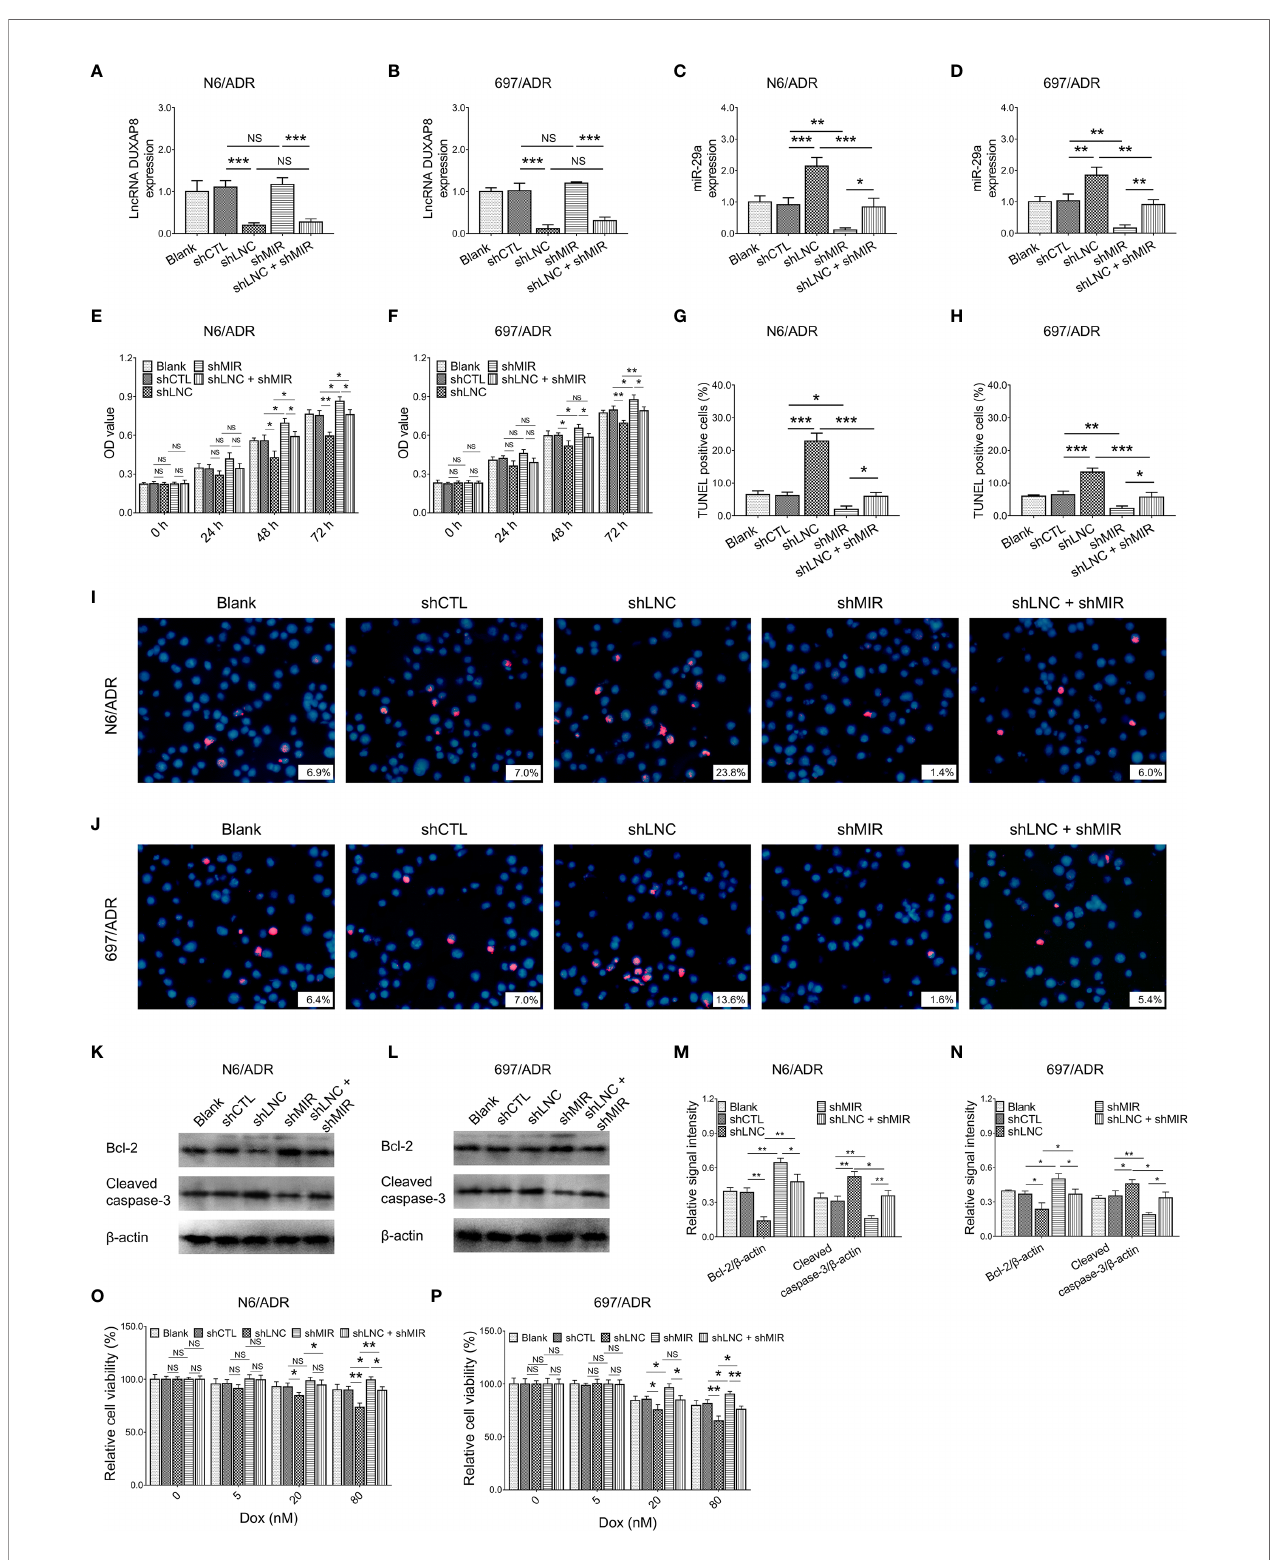
FIGURE 5 | Cell behaviors after lncRNA DUXAP8 and miR-29a modi fi cation. LncRNA DUXAP8 (A, B) , miR-29a (C, D) , cell proliferation by CCK-8 (E, F) , cell apoptosis rate (G – J) , apoptotic marker expressions (K – N) , and chemosensitivity to Dox (O, P) among blank, shCTL, shLNC, shMIR, and shLNC +shMIR groups in N6/ADR cells and 697/ADR